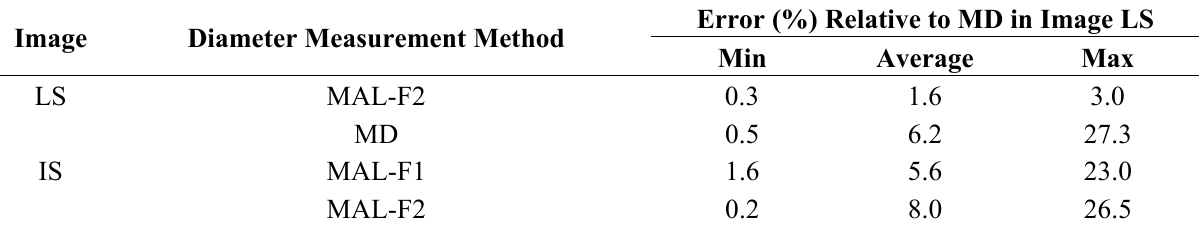
Table 4. Relative error in the estimate of fruit diameter: low illumination case. Image